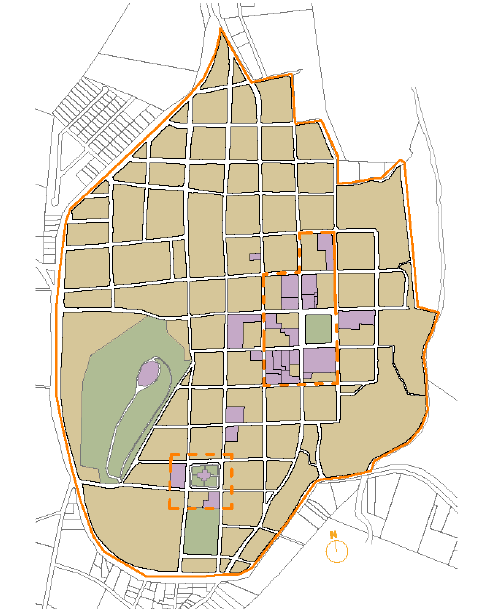
Figure 2. Skeched plan of the town of Gracias (Lempira), including the proposed area to be designated as a World Heritage Site (in dashed line). Source: Authors’ own